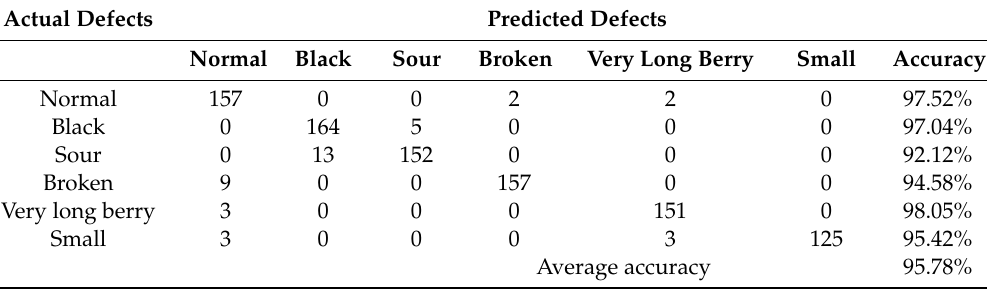
Table 3. Confusion matrix for defect types classification using k =